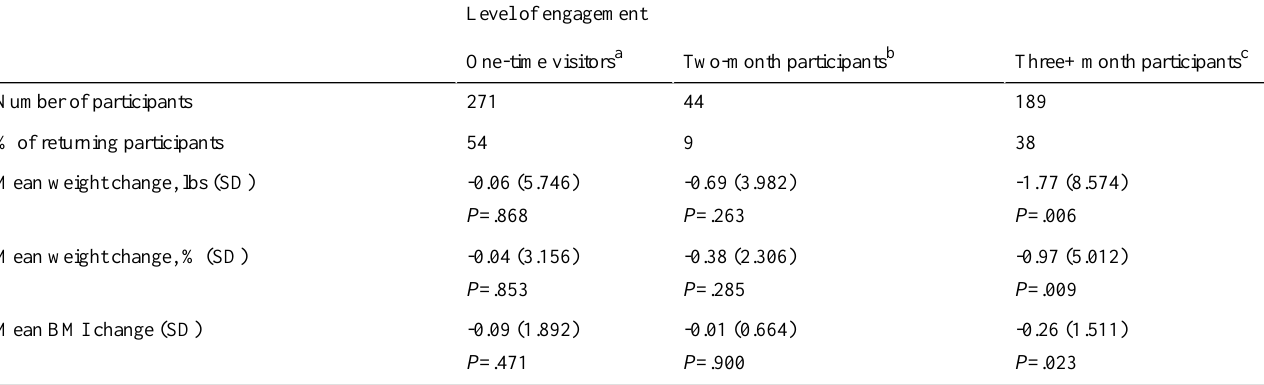
Table 2. Weight and BMI changes among returning participants.